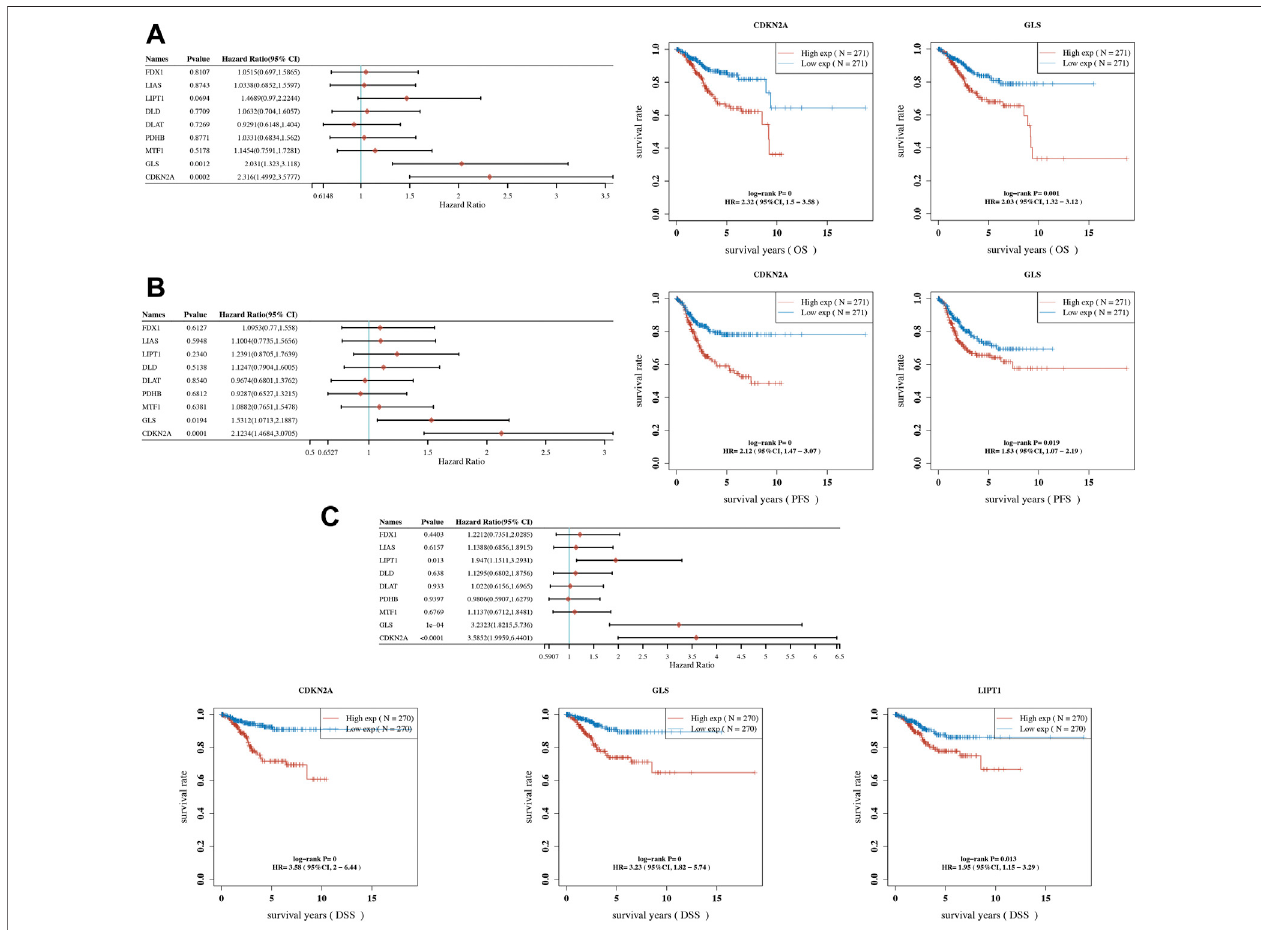
FIGURE 4 | Prognostic signi fi cance of cuproptosis-related genes (CRGs) in uterine corpus endometrial carcinoma (UCEC). (A) Result of overall survival analysis of CRGsinUCEC. (B) Resultofprogression-freesurvivalanalysisofCRGsinUCEC. (C) Resultofdisease-freesurvivalanalysisofCRGsinUCEC.OS,overallsurvival;PFS, progression-free survival; DFS, disease-free